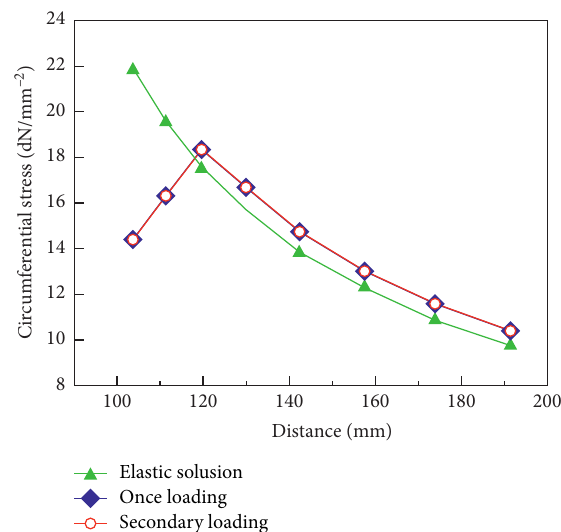
Figure 5: Radial displacement on the surface under one load.